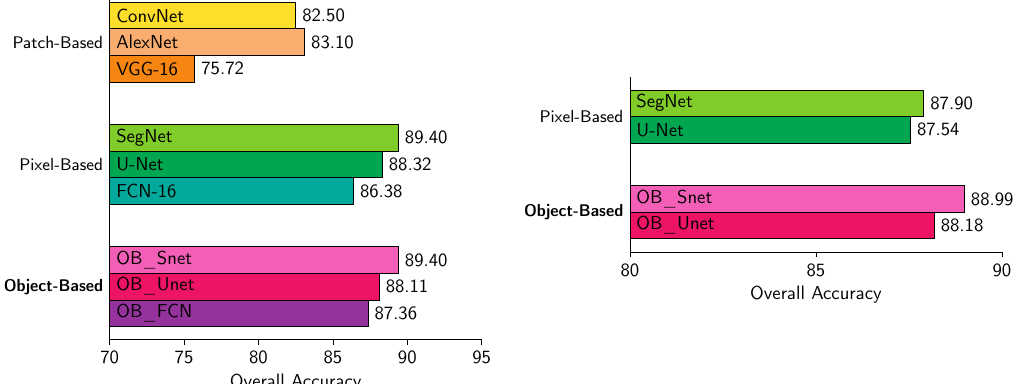
Figure 3. The resulting Overall Accuracy (OA) rates for the Vaihingen ( left ) and Postdam ( right ) datasets after the application of the developed object-based learning frameworks as well as the current state-of-the-art (either patch-based or pixel-based) learning networks.